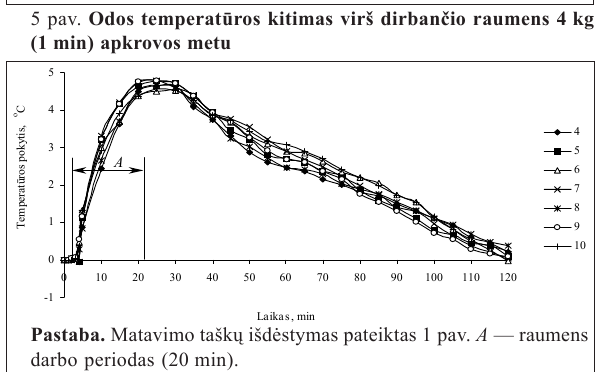
palaikyti. Visa gaunama ir fiziologiniam darbui i(cid:154)eikvota energija paver č iama (cid:154)iluma, kurios dalis pa(cid:154)alinama į aplink ą per k ū no i(cid:154)orinius pavir(cid:154)ius. Esant ramyb ė s b ū senai, (cid:158)mogaus odos lokali tem- perat ū ra yra pastovi. Fizinio darbo metu į bendr ą organizmo veikl ą į sitraukia atskiros raumen ų grup ė s. Priklausomai nuo fizin ė s veiklos pob ū d(cid:158)io tam tikros raumen ų grup ė s gauna apkrov ą , susitraukin ė ja griau č i ų raumenys, i(cid:154)siskiria (cid:154)iluma. Raumens į (cid:154)ilim ą